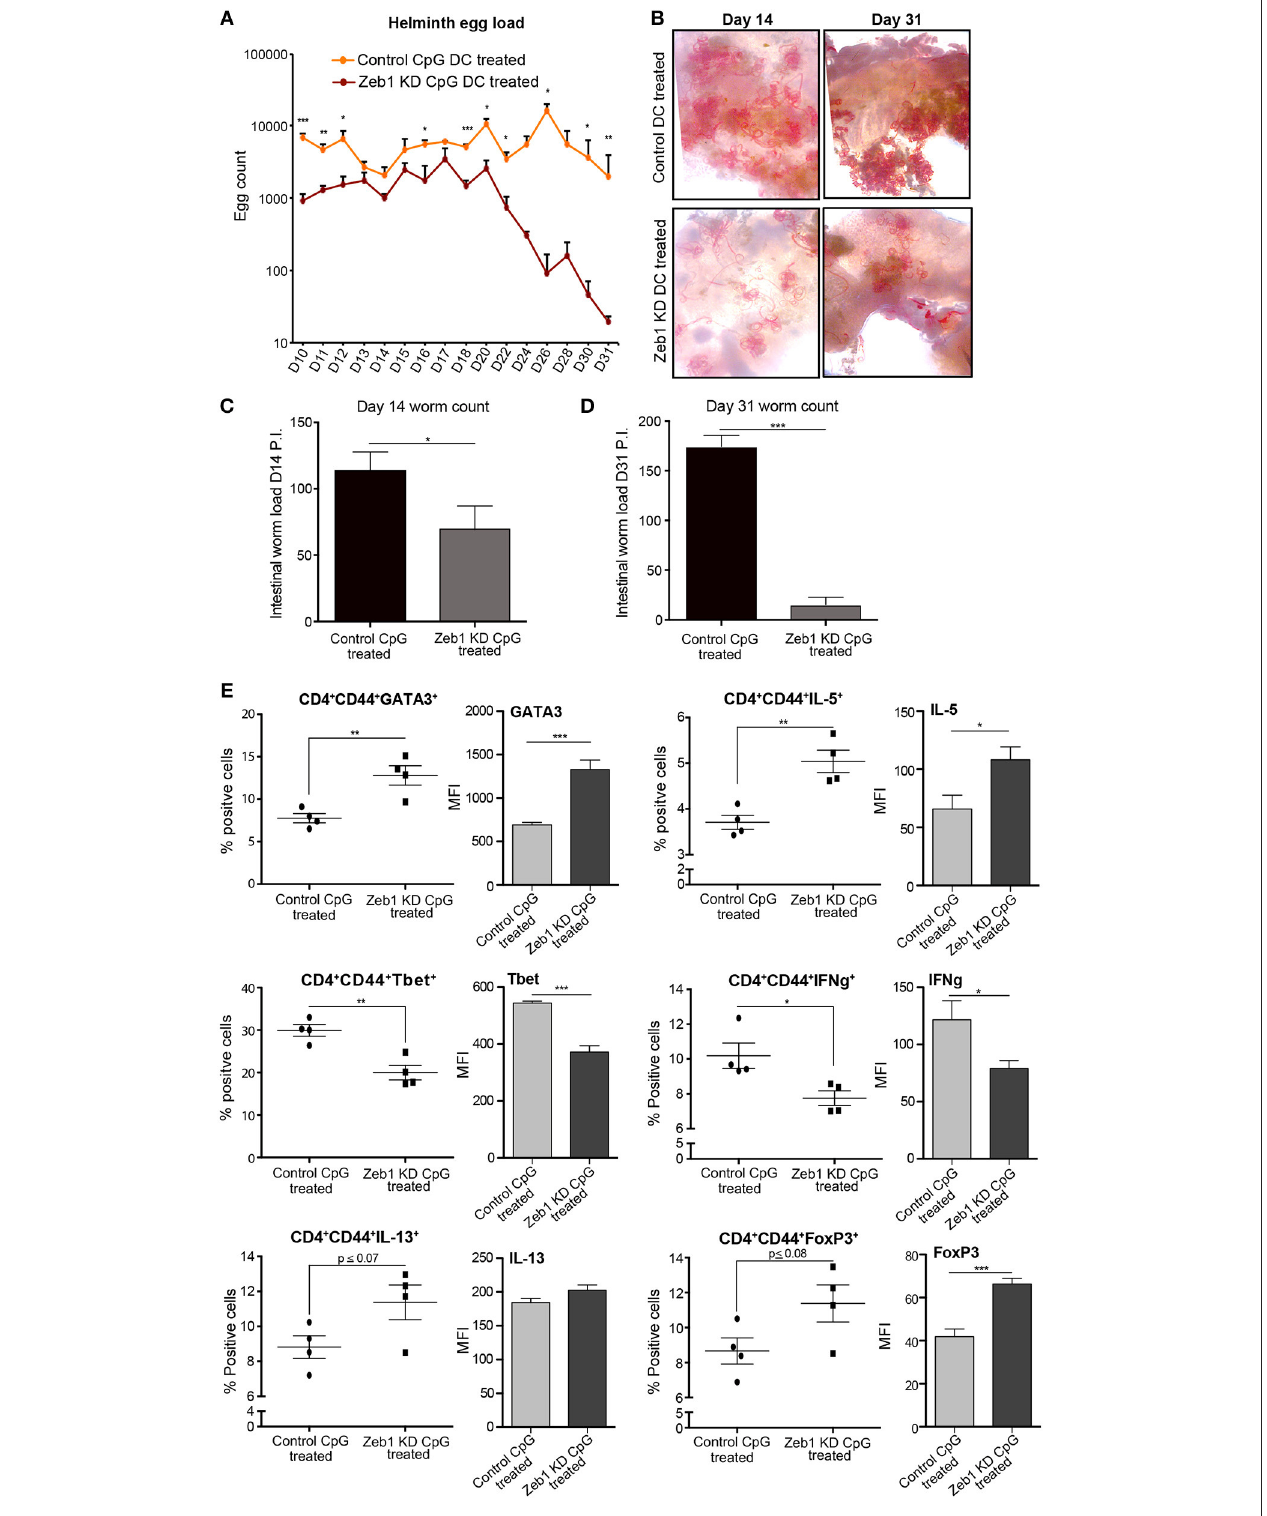
FIGURE 5 | Adoptive transfer of CpG activated Zeb1 KD cDC1 MutuDCs in helminth-infected mice enhances worm clearance by increasing Th2 responses. (A) Line-graphs depicting the Helminth egg counts in the feces of CpG pulsed Zeb1 KD CD8 α + cDC1 MutuDCs and control DC treated mice from D10 to D31. The mice were infected with H. polygyrus larvae at D0 and treated with CpG pulsed control and Zeb1 KD CD8 α + cDC1 cells consecutively at D7, D9, and D11. The egg